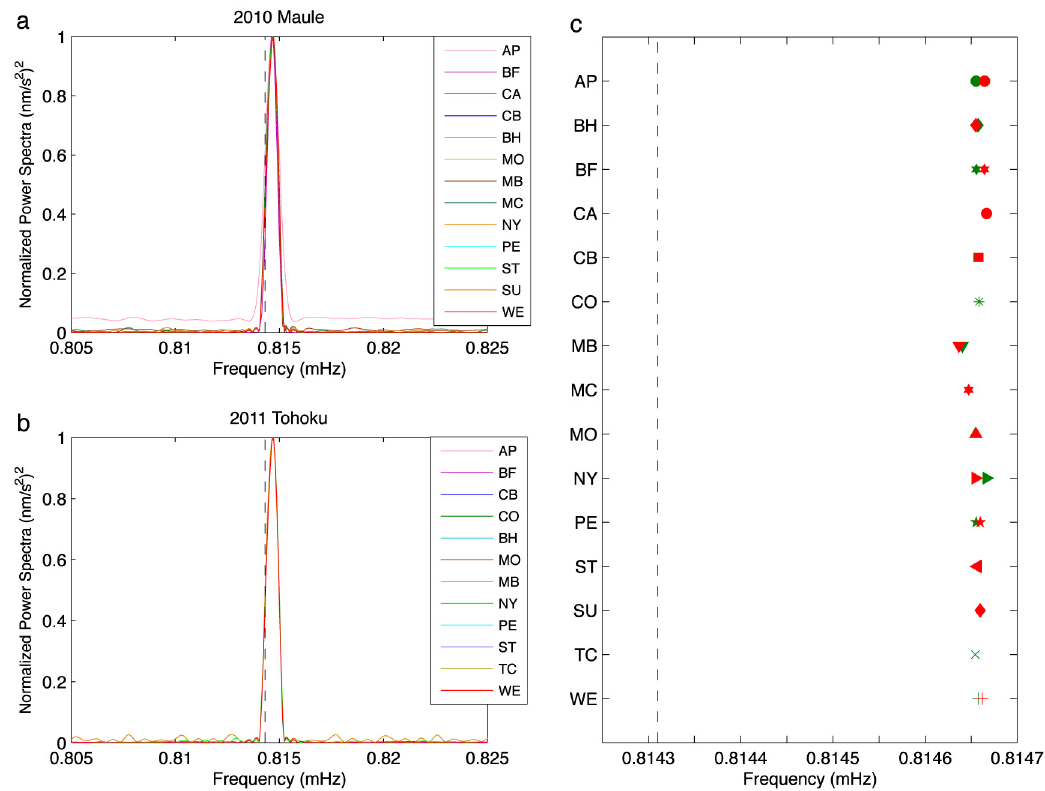
S . (a) The results of 13 residual gravity time series after the 2010 Maule event; (b) the results of 12 resid- Figure 2. The power spectra of 0 0 ual gravity time series after the 2011 Tohoku; (c) the estimated frequencies from different series, the red symbols (e.g., circle point, squares, etc.) indicate the results obtained from the 2010 event, and the green ones indicate the results obtained from the 2011 event (hereafter the same). The corresponding theoretical frequency based on PREM is denoted by vertical dashed lines.